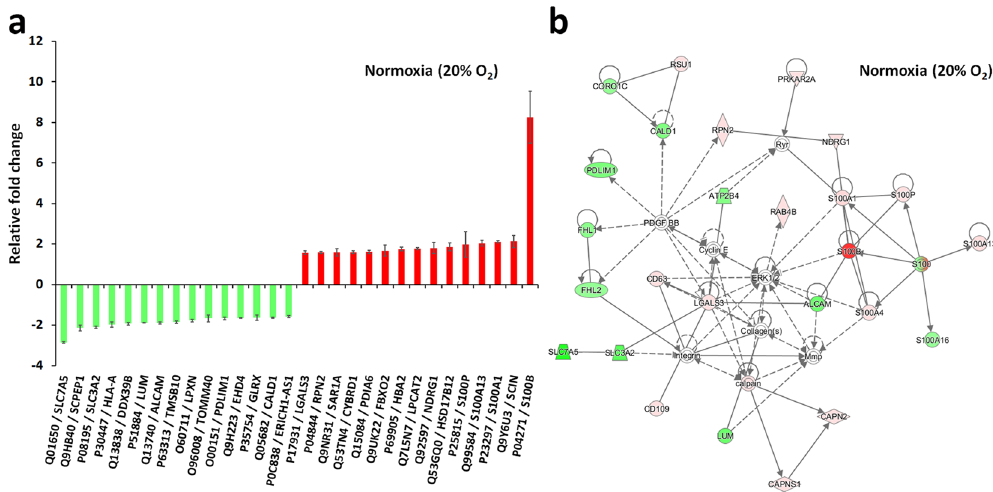
Figure 2. The fifteen most up-regulated and down-regulated proteins produced by a 28-day exposure to 10 µ M of the Rho-kinase inhibitor Y-27632 ( a ). An IPA ® protein pathway analysis suggested a molecular network with the highest number of focus molecules (focus molecules 26, score 59) ( b ). This network was predicted to connect to organismal abnormalities and cancer. Error bars indicate 95% confidence intervals ( n =